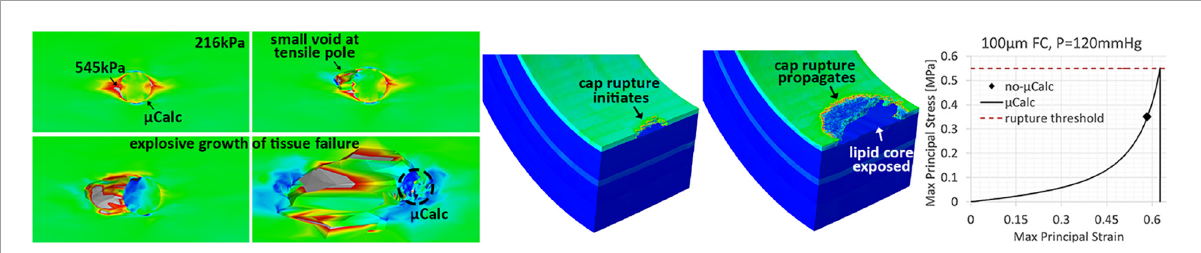
FIGURE5 Illustration of the tissue failure mechanism and rupture propagation due to the presence of a spherical micro-calcification. (Left) The µ Calc amplifies the tissue background stresses by a factor of about 2.5 at its tensile poles. When these stresses exceed the threshold for rupture, small voids start forming in these regions. If the tissue continues to stretch, the voids grow explosively through the tissue. (Center) Cap rupture initiates as a small fissuring at the luminal side and then propagates as the tissue is more exerted, until exposing the underlying lipid core. (Right) Comparison of the stress-strain response of a 100 µ m cap with and without one spherical µ Calc, under the same systolic